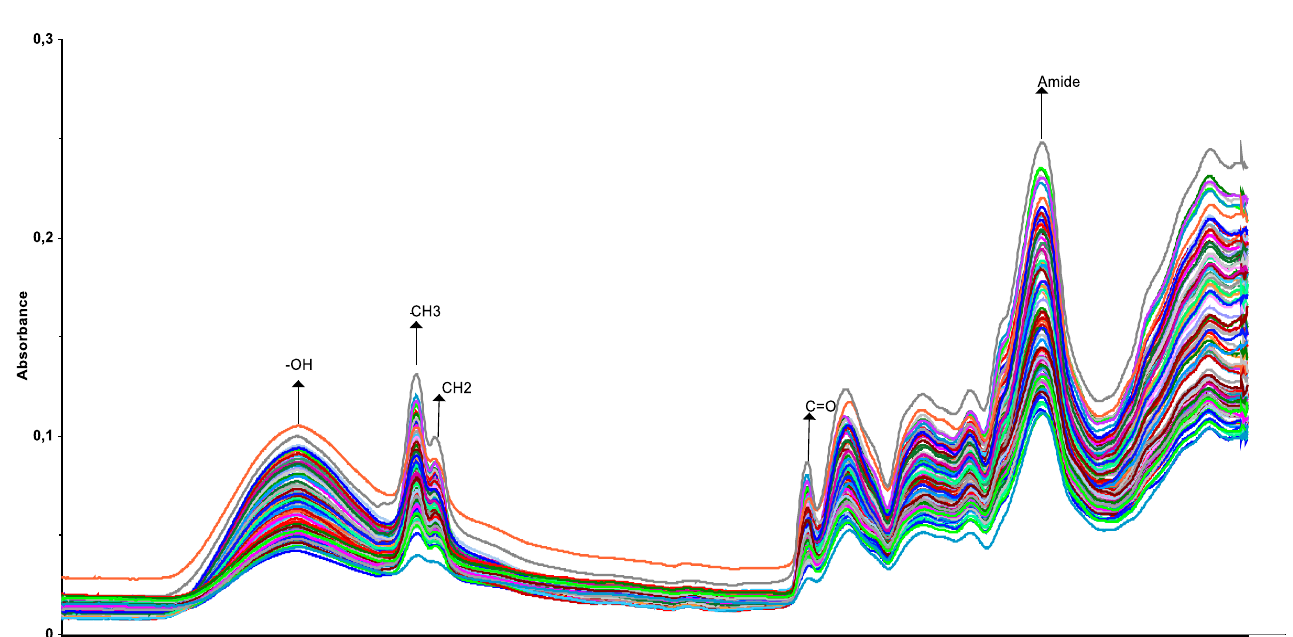
Figure 2. The MIR spectra of the chili samples are between 4000–400 cm −1 .